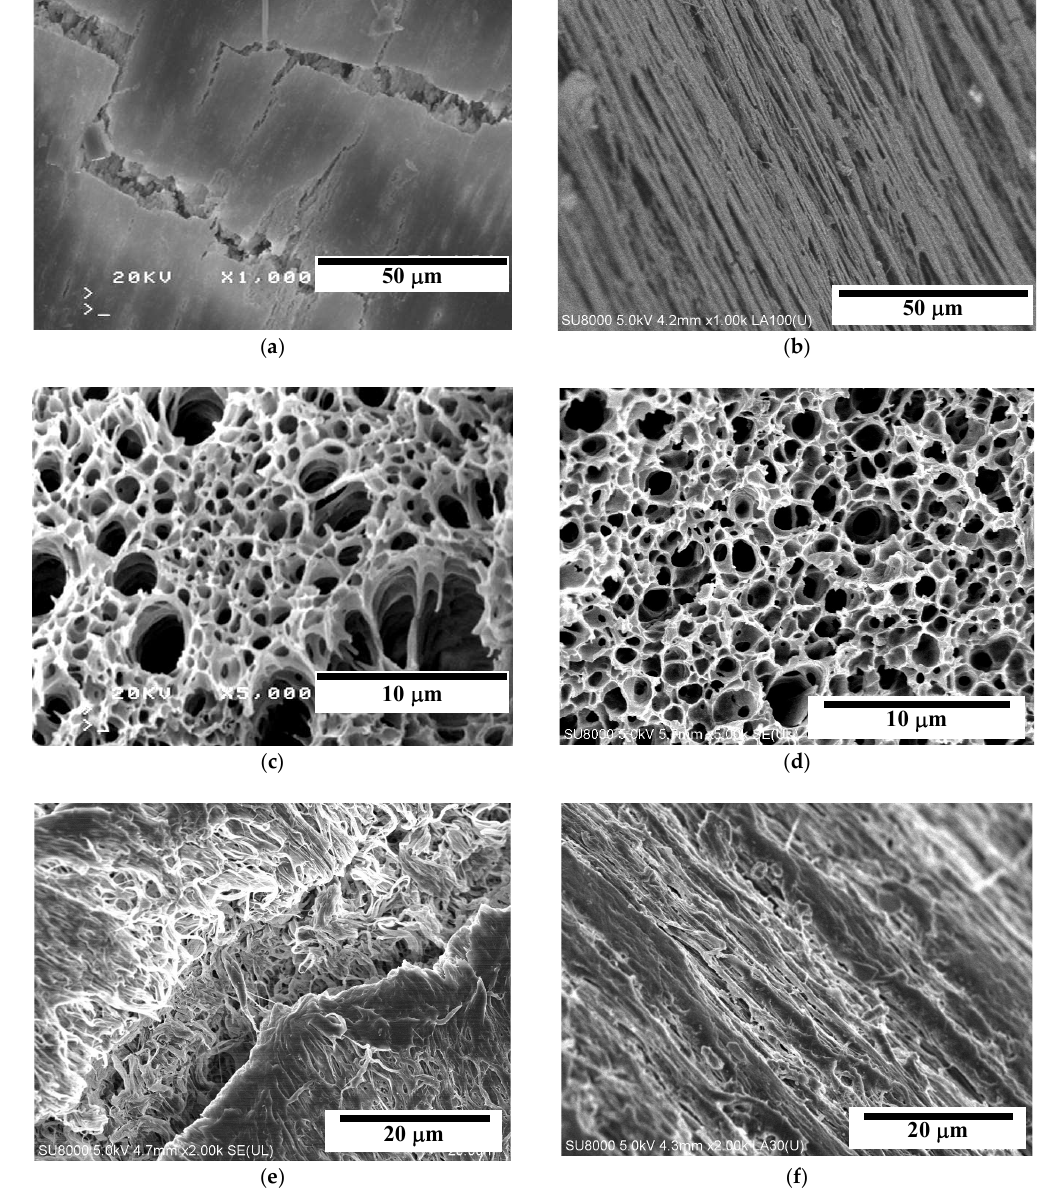
Figure 2. SEM images of new capillary membranes. Membrane PP-N: ( a ) external surface, ( b ) internal surface, ( c ) cross-section. Membrane PP-T (with talc): ( d ) cross-section, ( e ) external surface, ( f ) internal surface.